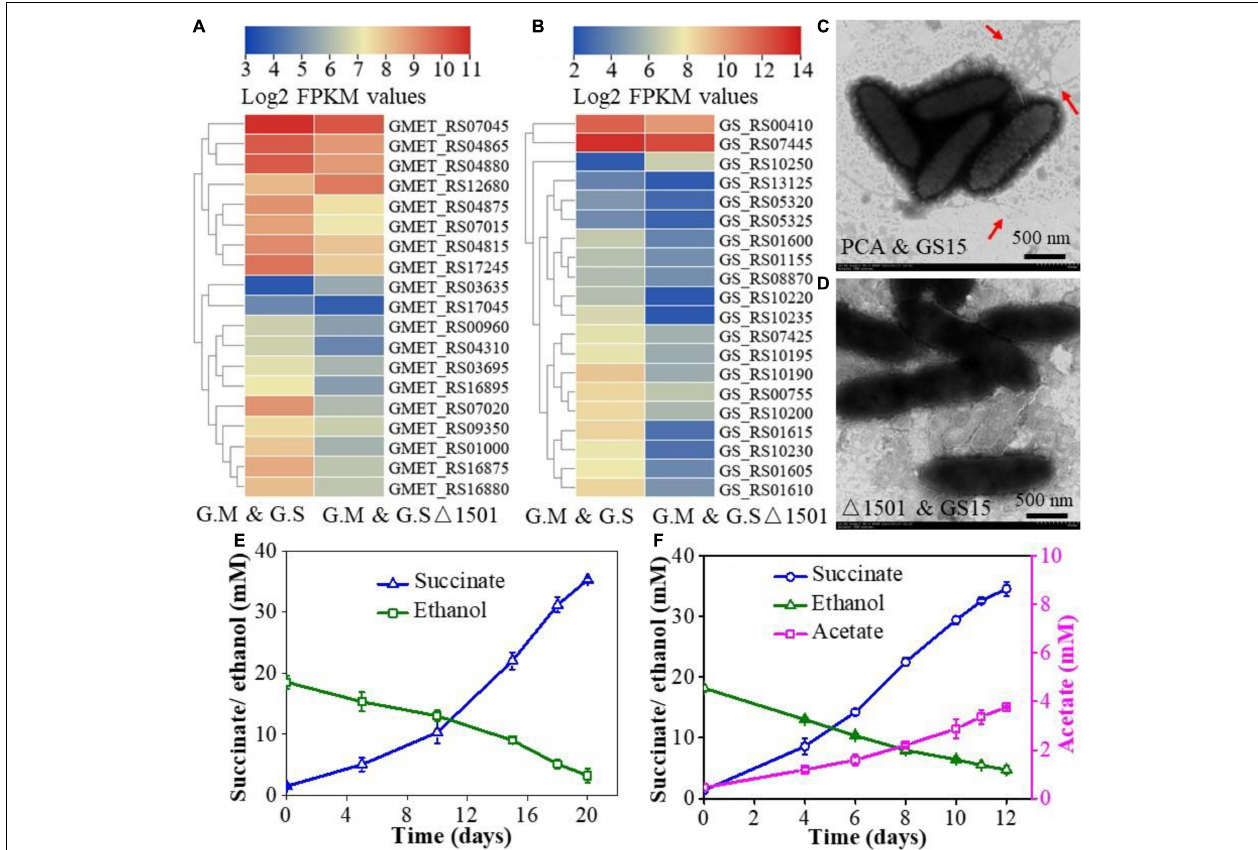
FIGURE 4 | Heat map comparison of pili-related genes of G. metallireducens (A) and G. sulfurreducens (B) in the GS15 and PCA co-culture and the GS15 and PCA (cid:49) 1501 co-culture. Transmission electron microscopy (TEM) images of the GS15 and PCA co-culture (C) and GS15 and PCA (cid:49) 1501 co-culture (D) . Effects of granular activated carbon (GAC) addition on the syntrophic metabolism of the GS15 and PCA (cid:49) 1501 co-culture in the first generation (E) and metabolic stable period (F) .